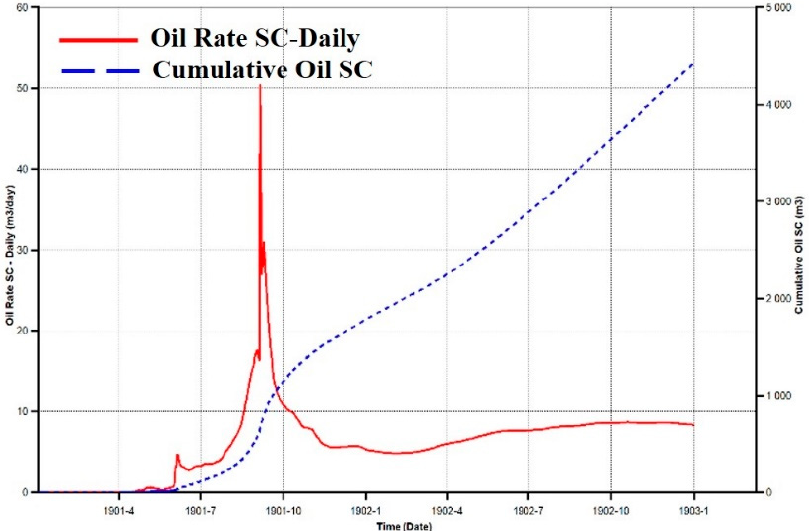
Figure 11. Daily oil production and cumulative oil production (with particle migration).